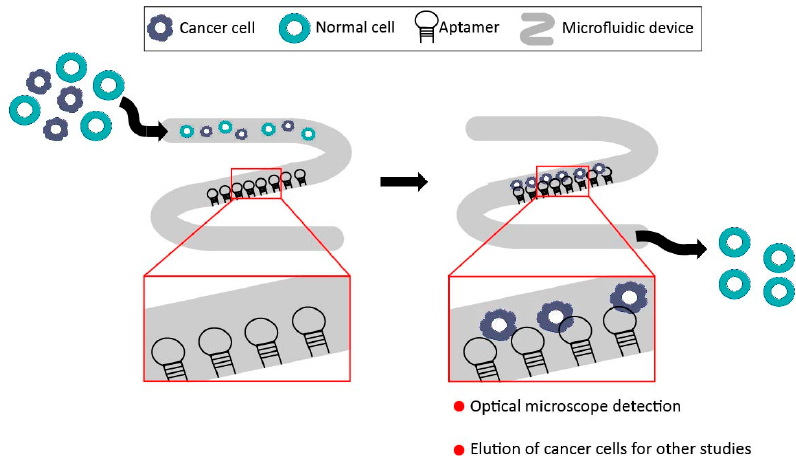
Figure 4. Schematic illustration of a microfluidic device, showing a middle region with immobilized aptamers. After the injection of the sample, cancer cells are trapped by specific aptamer-cell interaction, whereas normal cells pass through the device. In this sense, cancer cells can be detected by optical microscope observation of the middle zone, and also eluted for future experiments. This device allows the isolation of cancer cells from a heterogeneous mixture of cells by selective cell-capture of immobilized